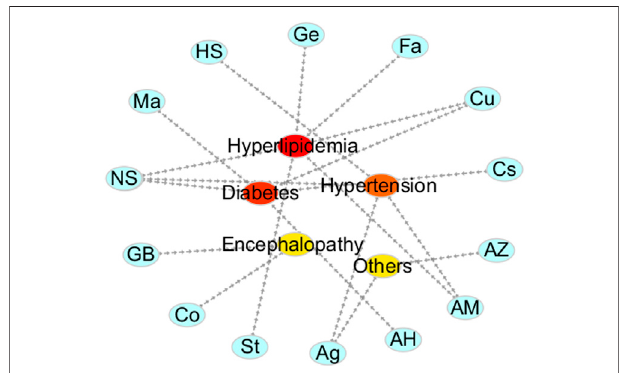
FIGURE5| ClinicalapplicationofsomeTMPsandnaturalproducts.The vasodilating TMPs and natural products are mainly used in the treatment of